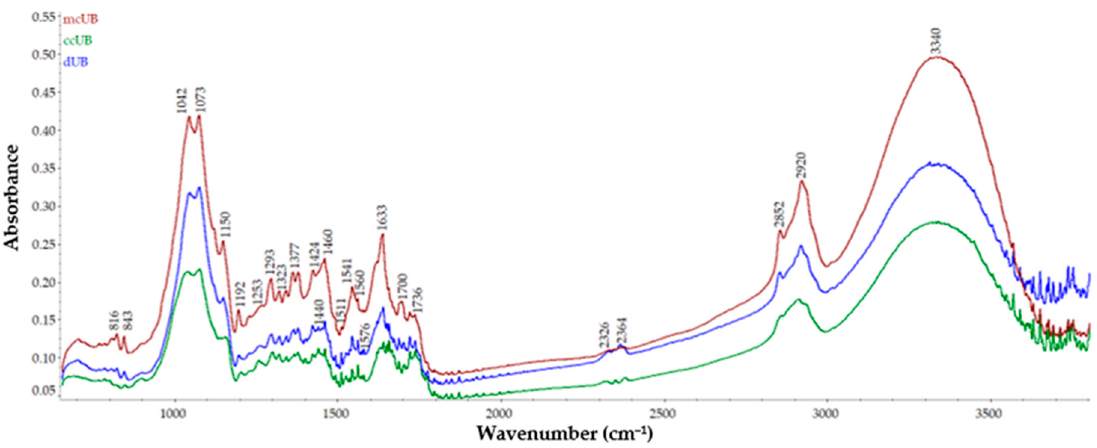
Figure 6. Overlay of FT-IR spectra of U. barbata dried lichen ( d UB), medulla–cortex ( mc UB), and central cord ( cc UB).